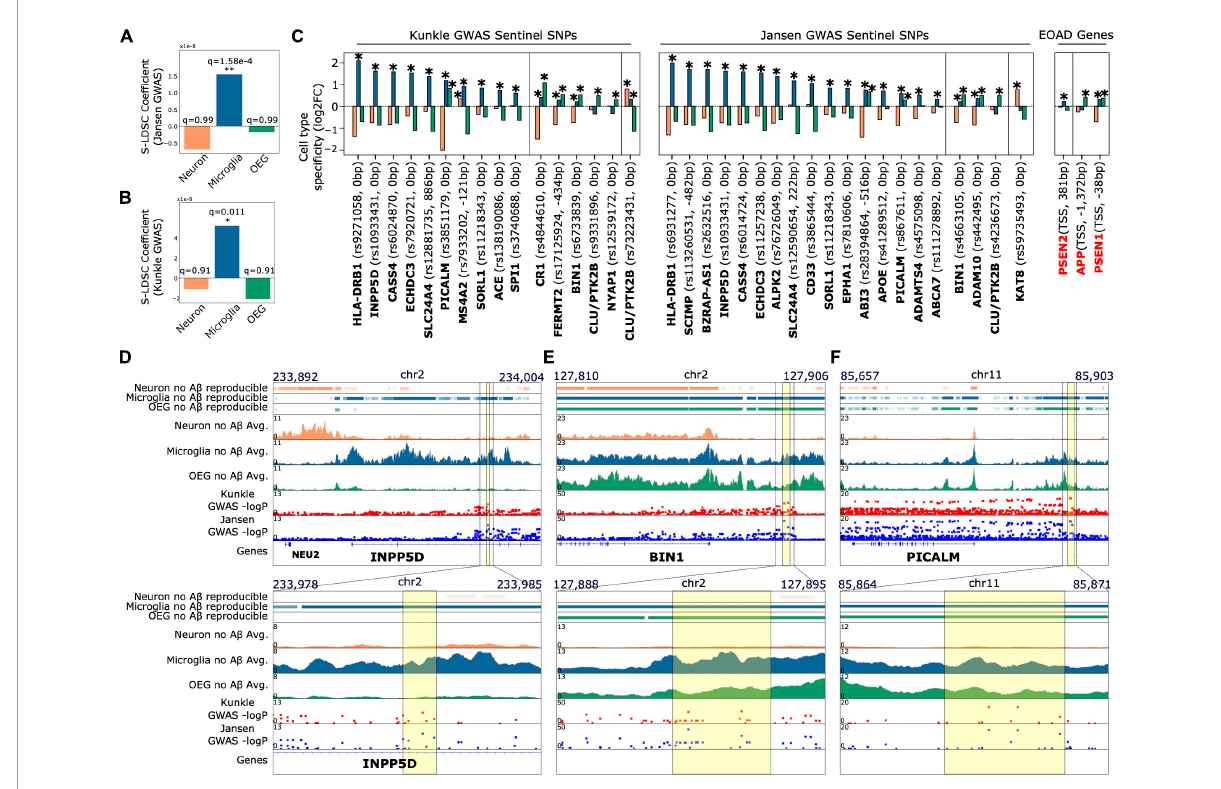
FIGURE2 AD associated SNPs derived from GWAS prefer to colocalize with peaks enriched in the microglial population relative to peaks enriched in the OEG and neuronal populations (A,B) . Results of stratified LD score regression from two AD GWAS studies (Jansen et al., 2019; Kunkle et al., 2019) and cell type-specific H3K27ac peaks. Plots show the estimated LD score regression coefficient for the three peak sets. Benjamini Hochberg FDR corrected q-values across the three tests for enrichment are indicated above each bar (C) . Cell type enrichment of peaks annotated to sentinel SNPs at AD risk loci identified by Jansen et al. (2019) and Kunkle et al. (2019). Plots show fold change (log2-transformed) of H3K27ac signal for each population against the other two populations for (i) in black: peaks closest to the sentinel SNP at each locus associated with AD from GWAS, and (ii) in red: promoter peaks of early onset AD risk genes ( APP , PSEN1 , PSEN2 ). ∗ Indicates DeSeq2 FDR q < 0.05 for the cell type-specific contrast. Sentinel SNPs that introduce missense mutations in proteins or SNPs where the closest H3K27ac peak is annotated > 1kb away are not included. This restriction was to ensure the analysis comprised only of SNPs that likely have functional effects on promoters or enhancer activity (D–F) top: Genome browser tracks of (i) reproducible peaks in each cell type for subjects without A β load, (ii) average H3K27ac signal in subjects without A β load for each cell type, and (iii) Manhattan plots of Jansen et al. (2019) and Kunkle et al. (2019) genetic variants. Plots are focused at loci where sentinel non-coding SNPs overlap with peaks enriched in non-neuronal cell types (d. INPP5D , e. BIN1 , f. PICALM ); bottom: zoomed in versions of the genome browser tracks displayed on top. INPP5D locus: the sentinel SNP rs10933431 overlaps with a peak that is enriched only in the microglial population; BIN1 locus: the top two AD-associated SNPs based on